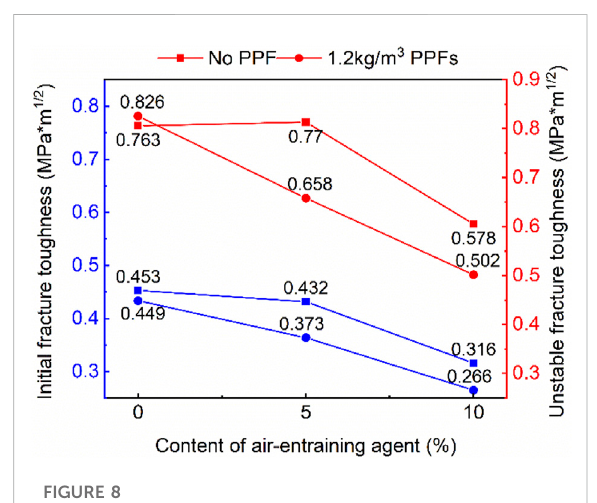
FIGURE 8 Effect of air-entraining agent on initial fracture